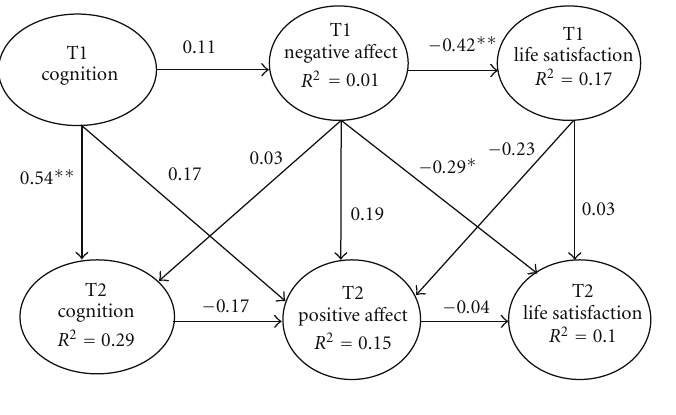
Figure 1: Negative a ff ect model of life satisfaction among centenarians at Time 1 ( N = 136) to Time 2 ( N = 68). Note. ∗ P < . 05, ∗∗ P < . 01.